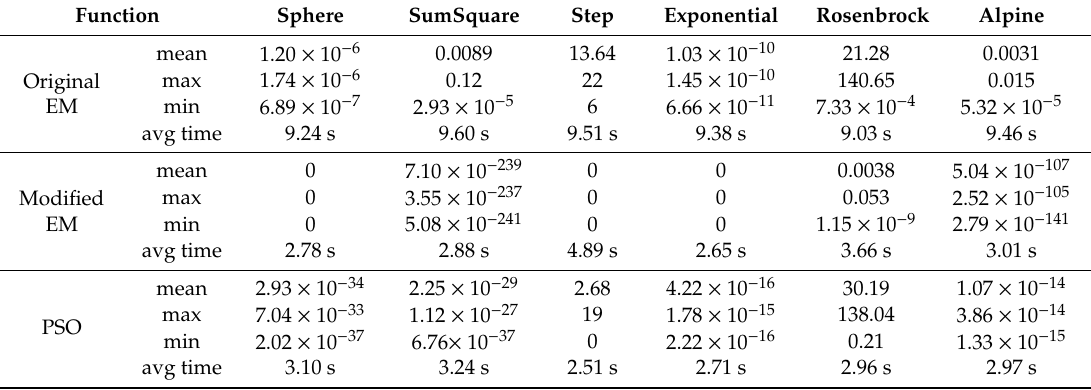
Table 2. Accuracy comparison on the six benchmark functions with dimension n =